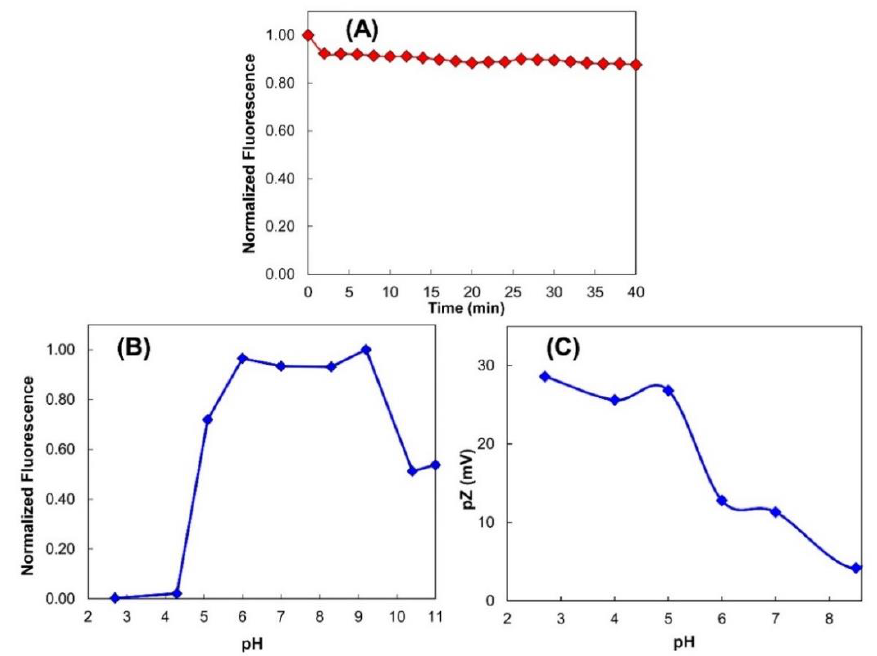
Figure 3. ( A ) Stability of CdTe/CA QDs, ( B ) normalized fluorescence of CdTe/CA QDs at different pH, and ( C ) variation of CdTe/CA QD zeta potential with